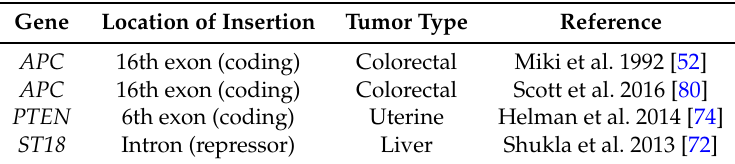
Table 2. Likely driver mutations caused by somatic L1 retrotransposon insertions in known proto-oncogenes and